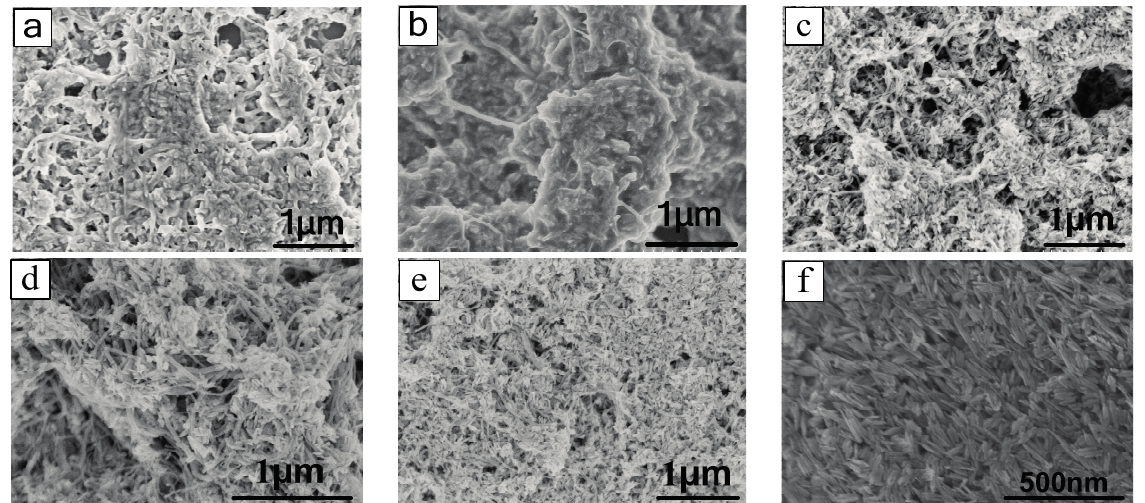
Figure 4. SEM image of ( a ) 0.6% CNT & Fe 2 O 3 (T = 100 °C); ( b ) 0.6% CNT & Fe 2 O 3 (T = 150 °C); ( c ) 0.6% CNT & Fe 2 O 3 (T = 200 °C); ( d ) 0.6% CNT & Fe 2 O 3 (T = 250 °C); ( e ) 0.6% CNT & Fe 2 O 3 (T = 300 °C) and ( f ) Fe 2 O 3 (T = 200